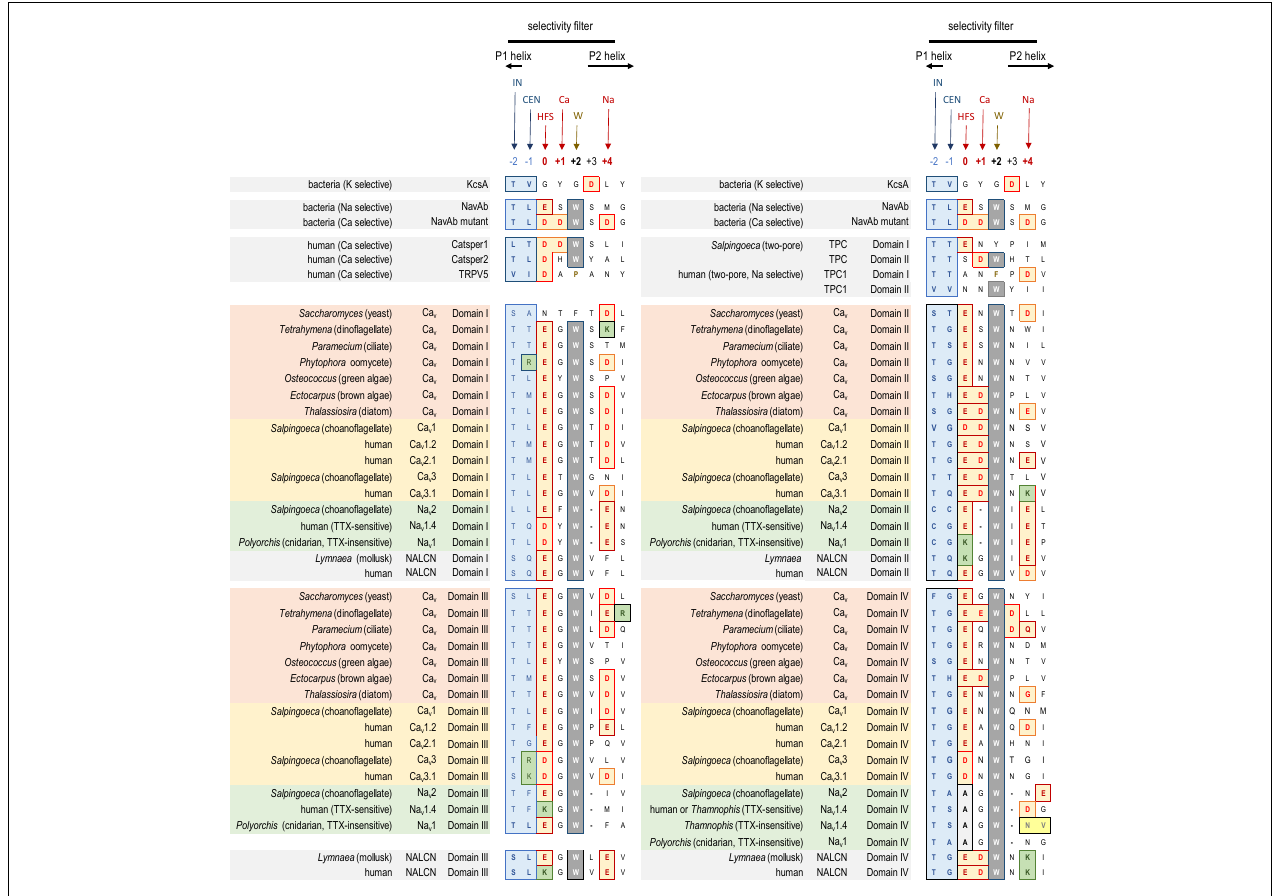
FIGURE 4 | Alignment of amino acid sequences contributing to the pore selectivity filters in representative calcium, sodium and NALCN channel homologs from single cell protists, yeast, algae, invertebrate and human, as well as 2 × 6 TM TPC channels, 1 × 6 TM channels (TRP, Catsper, and bacterial Na), and 1 × 2 TM channels (bacterial K). The pores of 4 × 6 TM channels from brown and green algae, yeast, single-cell choanoflagellates, cnidarian and mollusks are illustrated alongside human representatives, to illustrate the relationship of pore selectivity filters in different life forms. The selectivity filter is flanked by a descending P1 helix and ascending P2 helix. Residues contributing to the central (CEN) and inner (IN) sites of the selectivity filter are highlighted blue. Negative charged residues contributing to the selectivity filters (HFS sites), and to the ring of outer carboxylates are a red/brown color. A positively charged lysine residue (green color) populate the HFS site in Domain II or III of all Na v 1 channels. The aspartate (D) residue in Domain II at the Ca site, next to the HFS site, is conserved in Ca v 1, Ca v 2 and Ca v 3 channels. Na v 2 and Na v 1 channels are shortened in the pore selectivity filter in Domain II and lack the Ca site altogether. Instead, a glutamate (E) residue is conserved at the Na site (HFS+4) in Domain II of Na v 2 and Na v 1 channels. Exceptionally conserved tryptophans (W site) form inter-repeat hydrogen bonds that stabilize the pore loop region. Outer ring carboxylates (Na site, especially in Domain IV) contribute to TTX sensitivity, which when altered lowers TTX insensitivity. Note the amino acid changes (yellow colored residues) in Domain IV of the TTX-sensitive hNa v 1.4 and TTX-low sensitive channels from garter snake ( Thamnophis sirtalis ) that adapts to feed on TTX-ladened newts by neutralizing a negative charge at the Na site. Bacterial Na channel, Na v Ab becomes calcium-selective with aspartate (D) substitutions at the HFS, Ca and Na sites. Amino acid sequences were aligned using MUSCLE 3.7 (Edgar, 2004) within EMBL-EBI web interface (Chojnacki et al.,